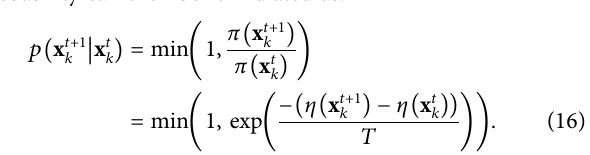
hypervolume of the bi-objective optimization is shown in Figure 1 . The pair-wise hypervolume generically can be calculated using the Lebesgue measure (Bartle, 1995) regardless of the objective function dimension. With this new fi tness function, the favorability of two solutions can be more easily discriminated, which as a result increases the solution diversity.